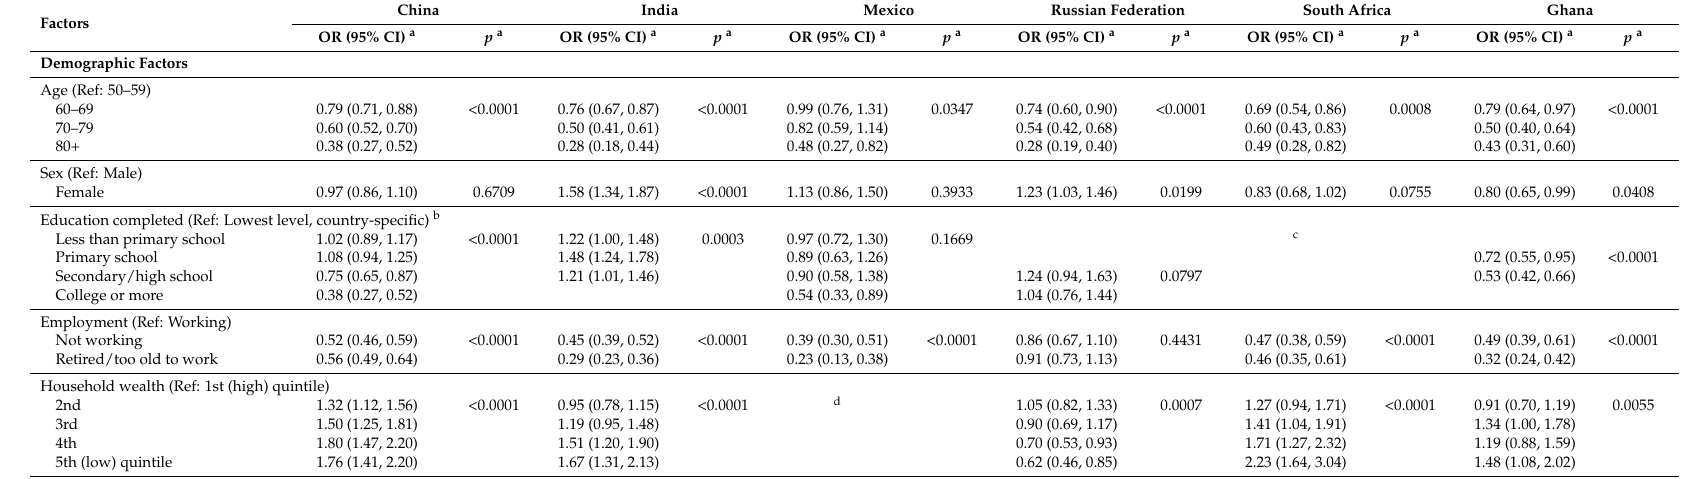
Multivariate associations of meeting physical activity guidelines with demographic, health and health risk, functional, interpersonal, and environmental